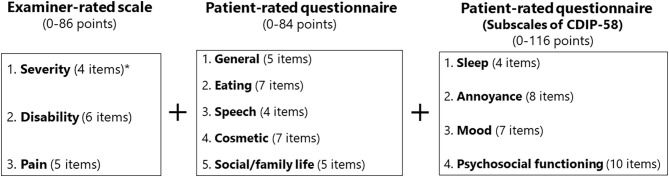
Structure of the oromandibular dystonia rating scale. The asterisk indicates that the subscale of severity was calculated from four of the six items according to the five subtypes of oromandibular dystonia (jaw closing, tongue, jaw opening, jaw deviation [including jaw protrusion], and lip dystonia).